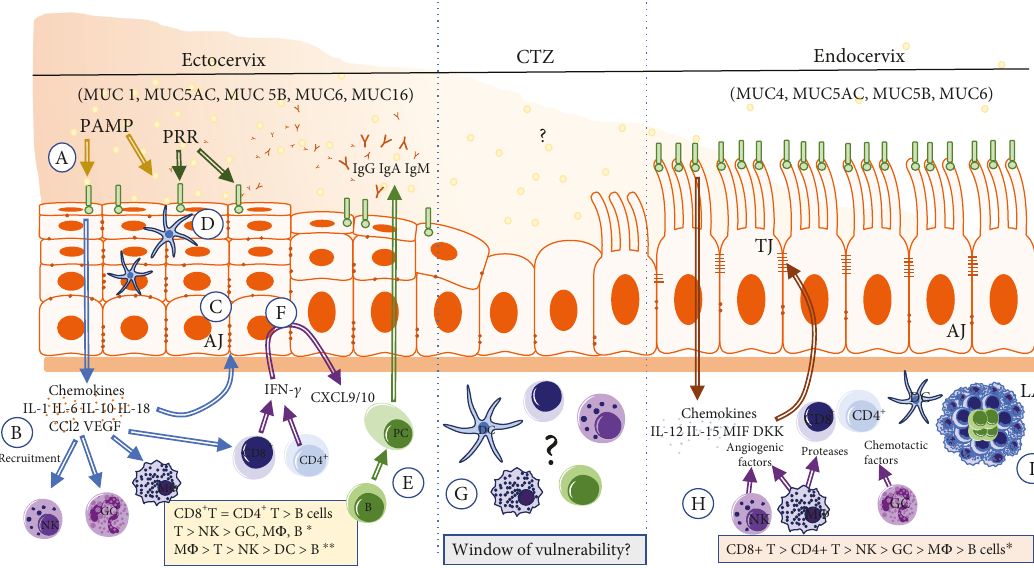
Figure 8: Comprehensive pro fi le of immunity in the three compartments of the cervix. This fi gure shows the overall innate and adaptive immunity of the pathogen-laden ectocervix and “ sterile ” CTZ and endocervix, as well as their associated cells and molecules. Full names of abbreviations: interleukin (1, 6, 10, 15, 18), interferon gamma (IFN- γ ), vascular endothelial growth factor (VEGF), macrophage migration inhibitory factor (MIF) and dickkopf homolog 1 (DKK1), pathogen-associated molecular patterns (PAMPs), pattern recognition receptor (PRR), and cervical transformation zone (CTZ). The illustration on the distribution of leukocytes is a modi fi cation from the following manuscripts: Givan et al. [57]; Trifonova et al. [58]; and Zhou et al.